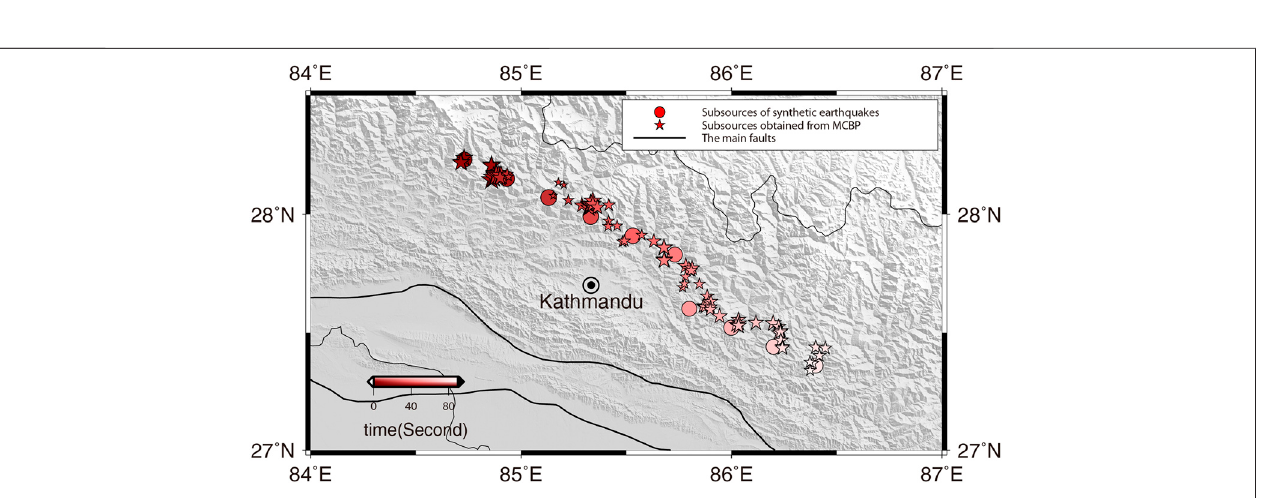
FIGURE 6 | Numerical test results from the MCBP